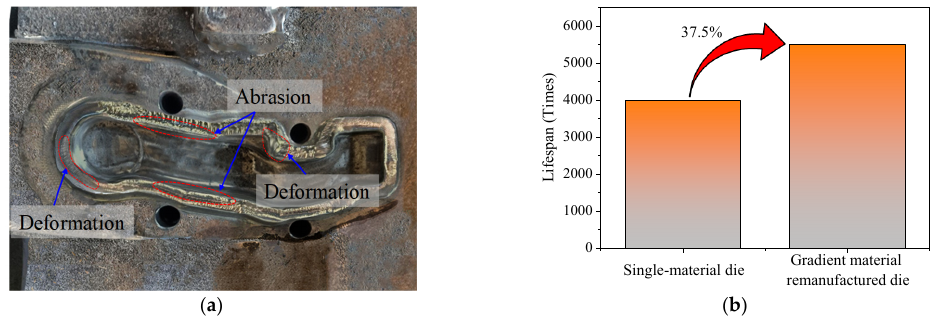
Figure 16. Production application of hot forging die remanufacturing: ( a ) the failed hot forging die; ( b ) removal of failure zone using carbon arc gouging; ( c ) wire and arc additive remanufacturing with multiple materials; ( d ) post-machining and polishing.